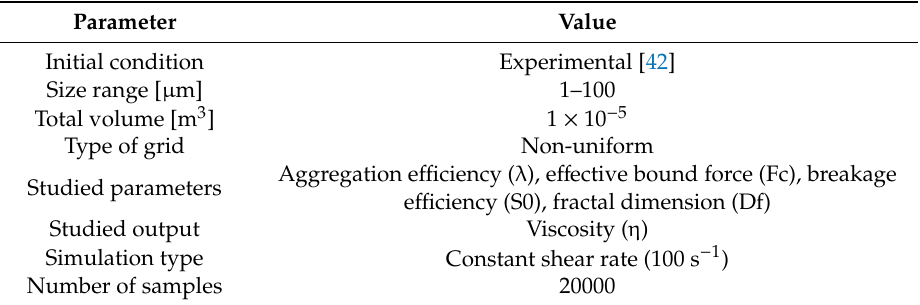
Table 2. Sensitivity analysis